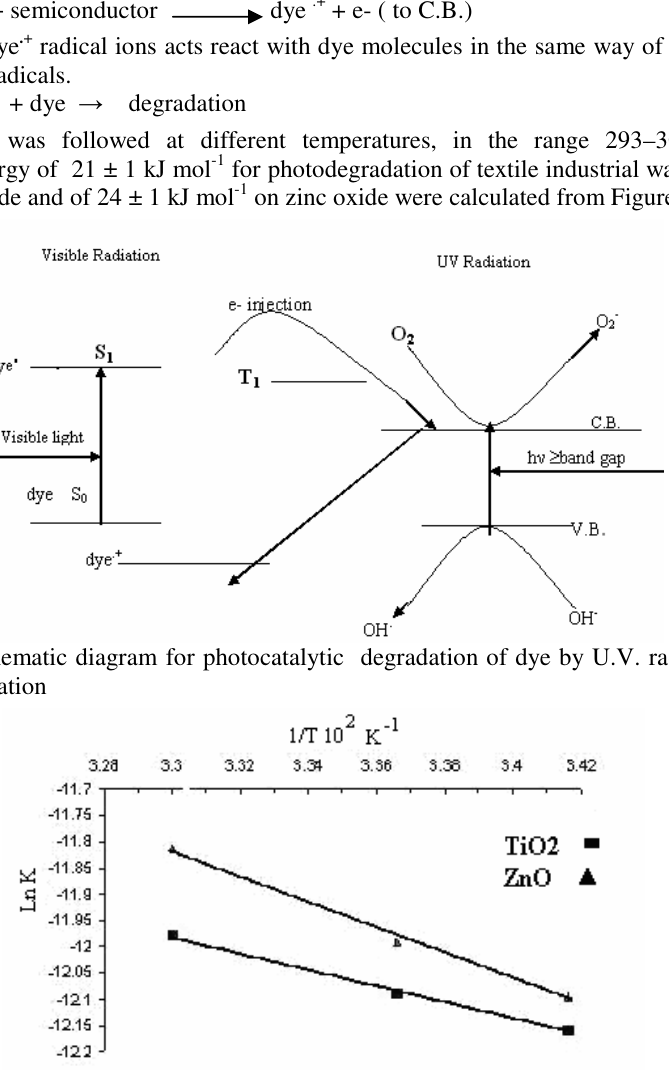
Figure 4. Temperature dependence for the photocatalytic degradation of textile industrial wastewater on titanium dioxide and zinc